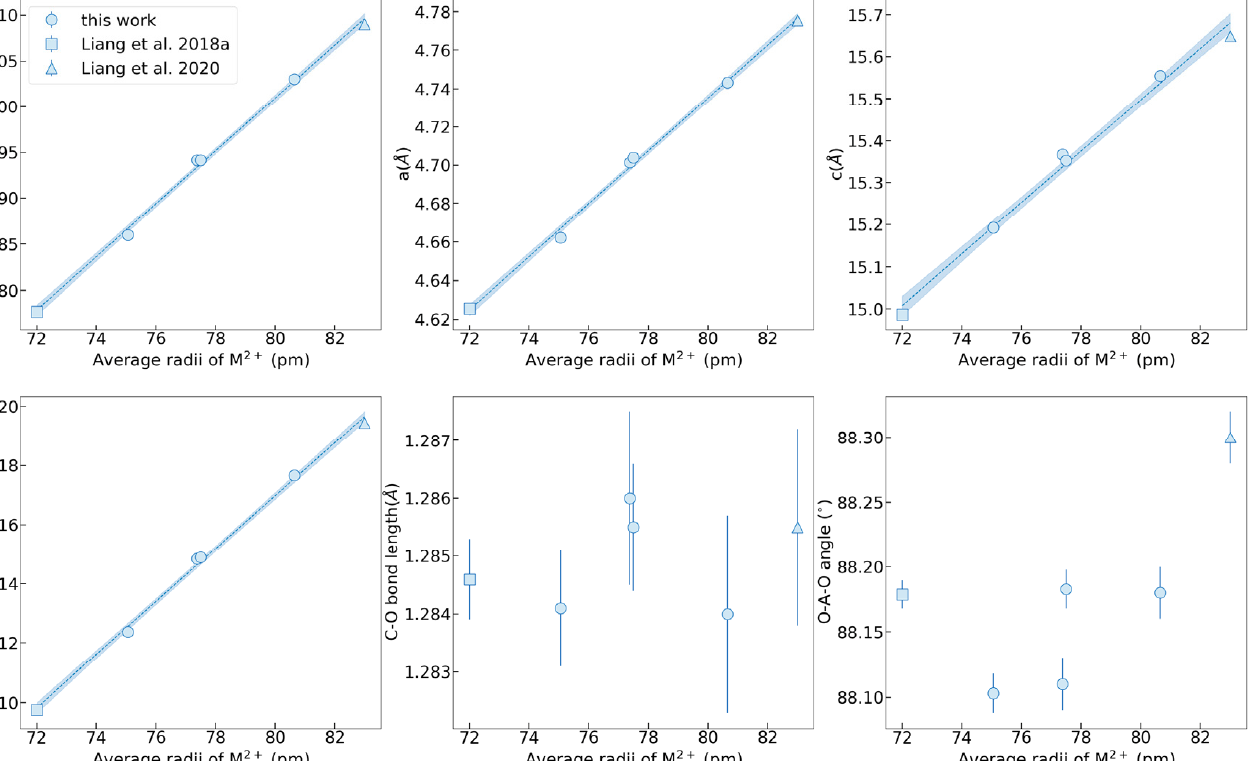
Figure 1. The single crystal lattice parameters of MFM, MF, FM, and MM compared with literature data of MgCO 3 and MnCO 3 with the change of the average ion radii. Data from Liang et al., 2018a, and Liang et al., 2020 [19,24].